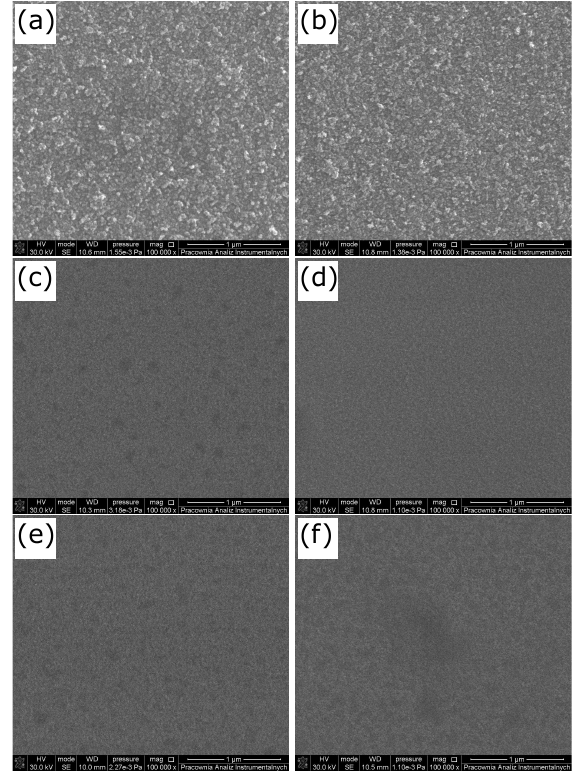
Figure A1. Scanning electron microscopy (SEM) images of ZnO layers deposited at RT: ( a ) not annealed and ( b ) annealed at 500 ◦ C, deposited at 100 ◦ C: ( c ) not annealed and ( d ) annealed at 500 ◦ C as well as deposited at 200 ◦ C: ( e ) not annealed and ( f ) annealed at 500 ◦